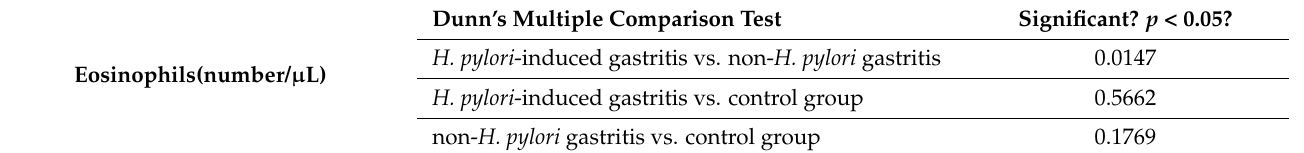
Table 6. The difference of median values of eosinophils between the three groups.